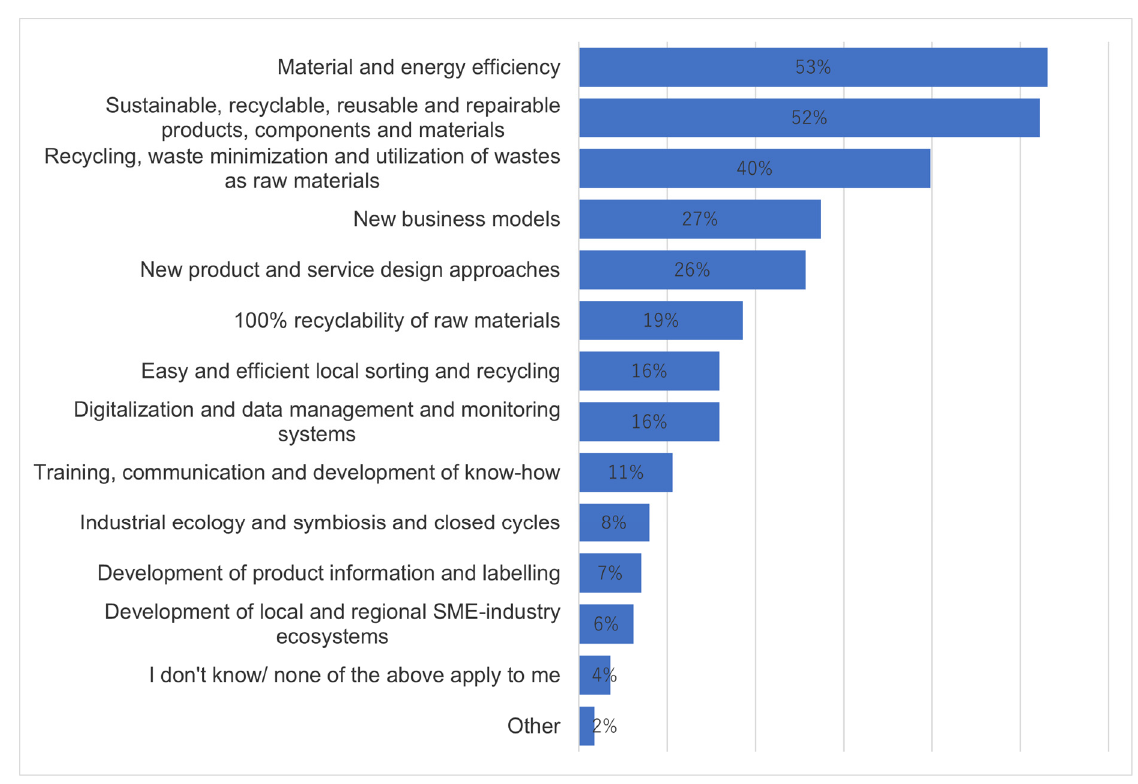
Figure 11. Best approaches to promote circular economy of material and energy use.